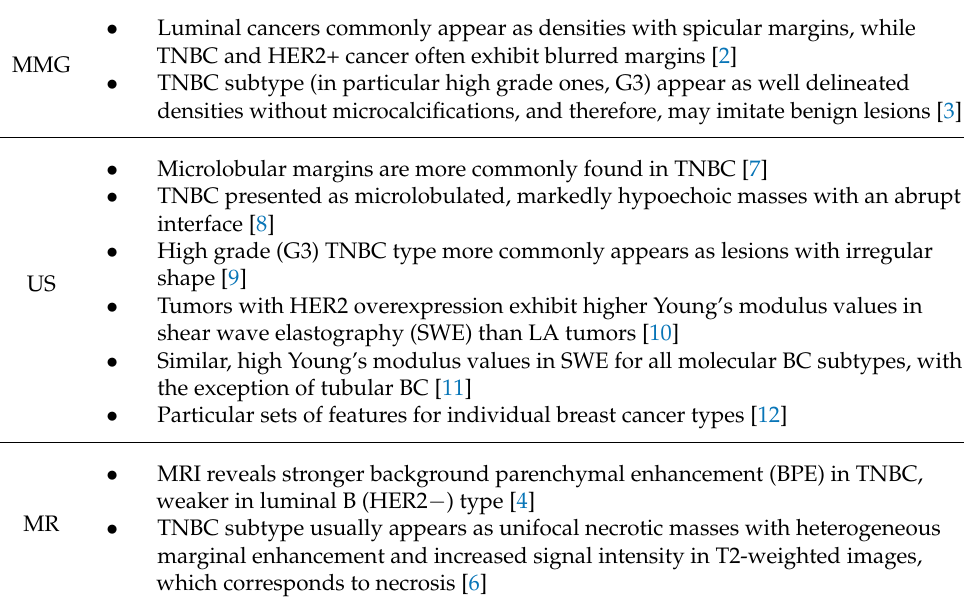
Table 1. Correlation between radiologic features and BC subtypes—literature